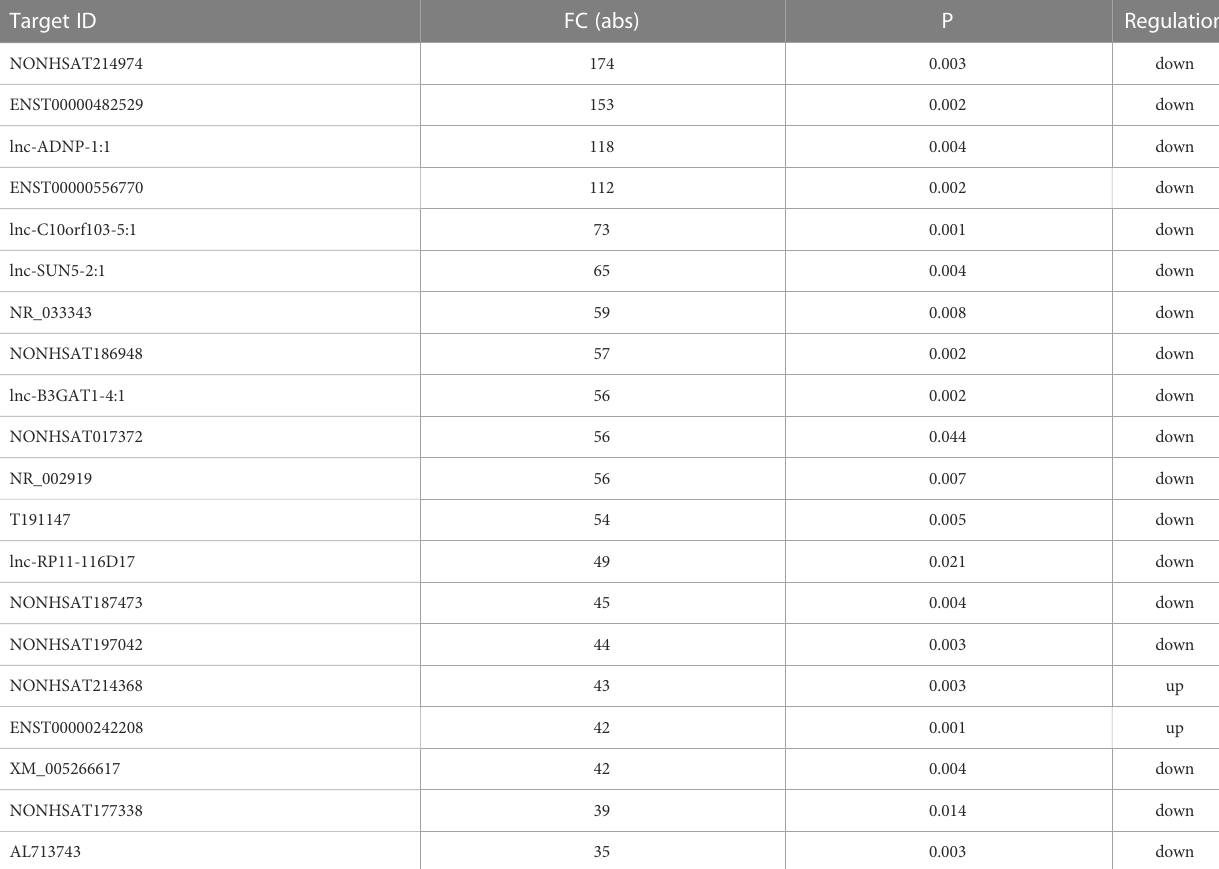
TABLE 1 Top 20 dysregulated lncRNA between gastric cancer with and without lymph node metastasis.